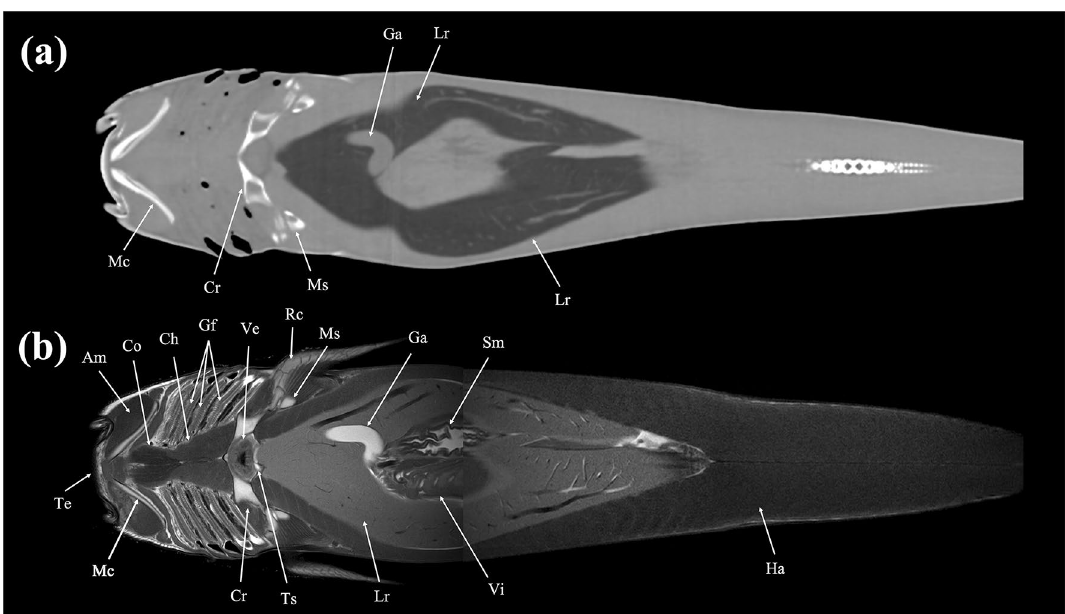
Figure 23. Dorsal ( a ) CT and ( b ) MR images of a banded houndshark ( Triakis scyllium ) at level 23 of Fig. 25. Am Adductor mandibularis, Co Coracomandibularis, Cr Coracoid bar, Ch Coracohyoideus, Ga Gall bladder, Gf Gill filament, Ha Hypaxial, Lr Liver, Mc Meckel’s cartilage, Ms Mesopterygium, Rc Radial cartilage, Sm Stomach, Te Teeth, Ts Transverse septum, Ve Ventricle, Vi Valvular